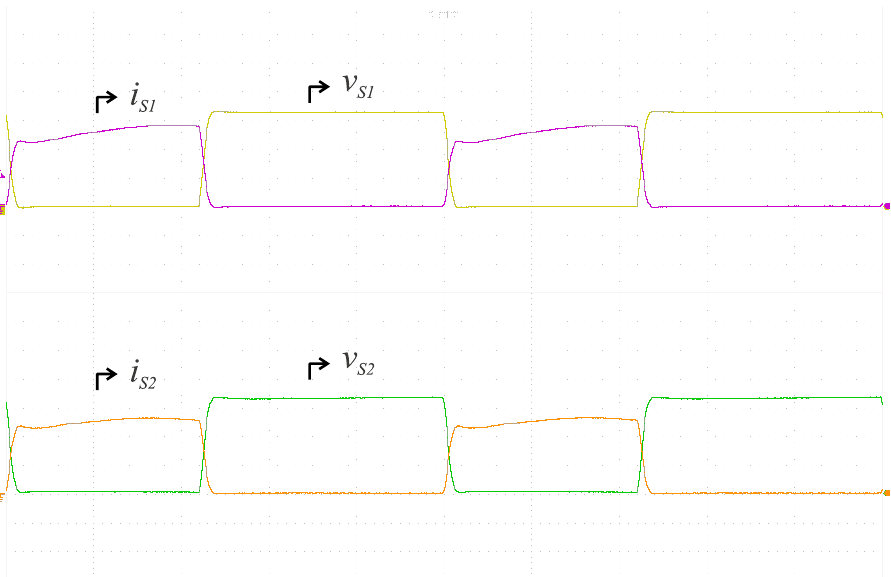
Figure 7. Top: switch S 1 voltage v S 1 (20 V/div) and current i s 1 (2 A/div); bottom: switch S 2 voltage v S 2 (20 V/div) and current i s 2 (2